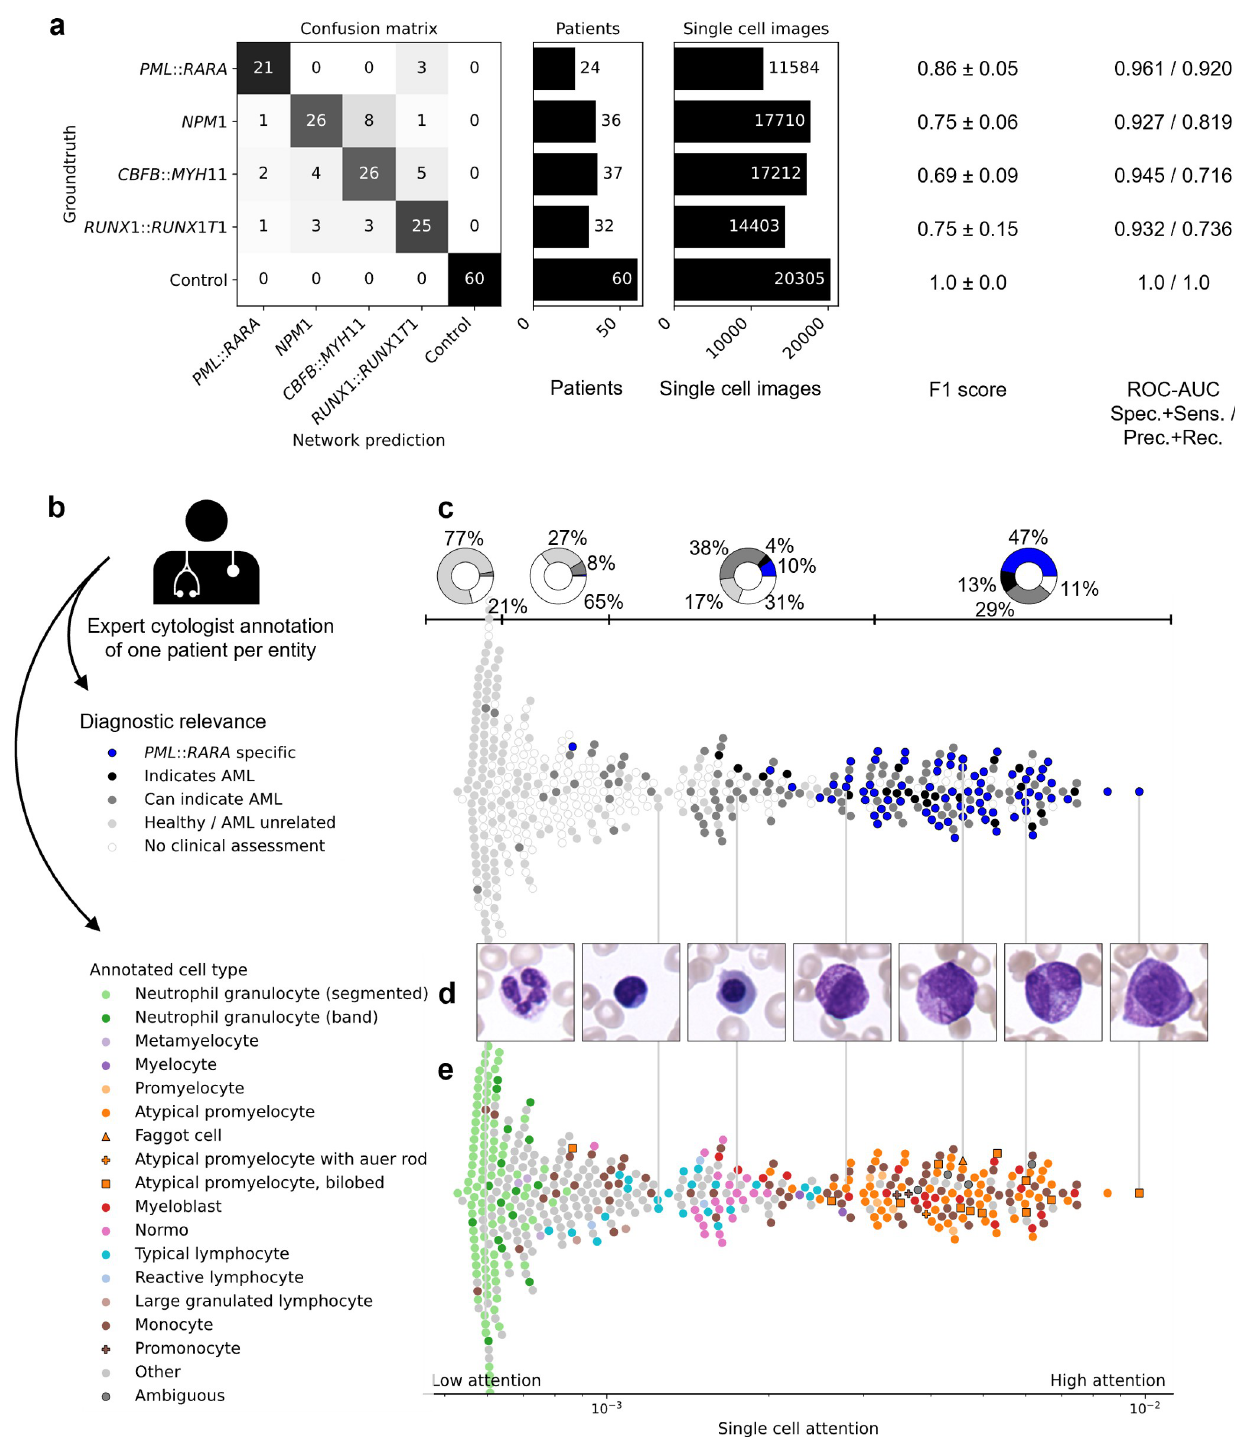
Fig 2. SCEMILA’s single-cell attention coincides with experts’ diagnostic relevance. (a) SCEMILA perfectly differentiated the 129 AML patients from 60 stem cell donors. The cytogenetically different AML genetic subtypes can be distinguished with F1 scores of 0.86 ± 0.05 ( PML :: RARA , mean ± s.d. from 5 cross validation runs), 0.75 ± 0.06 ( NPM1 ), 0.69 ± 0.09 ( CBFB :: MYH11 ), and 0.75 ± 0.15 ( RUNX1 :: RUNX1T1 ). Additionally, the ROC-AUC scores for both the specificity/sensitivity (left value) and the precision/recall characteristic (right value) are presented. (b) An expert cytologist annotated one patient per